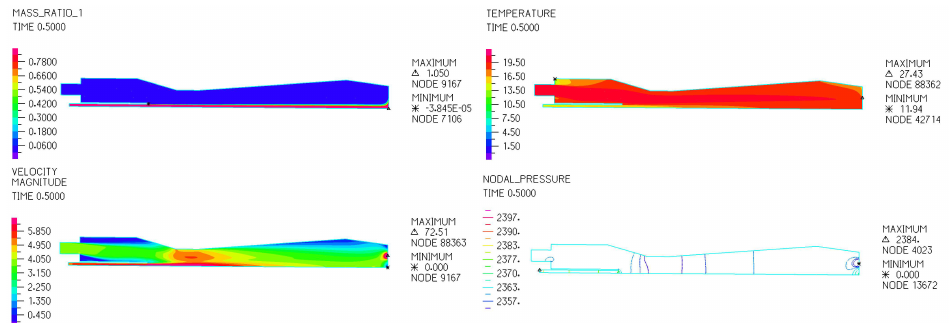
Figure 8. ADINA modeling results for two-dimensional axisymmetric turbulent flow model with heat transfer and mass